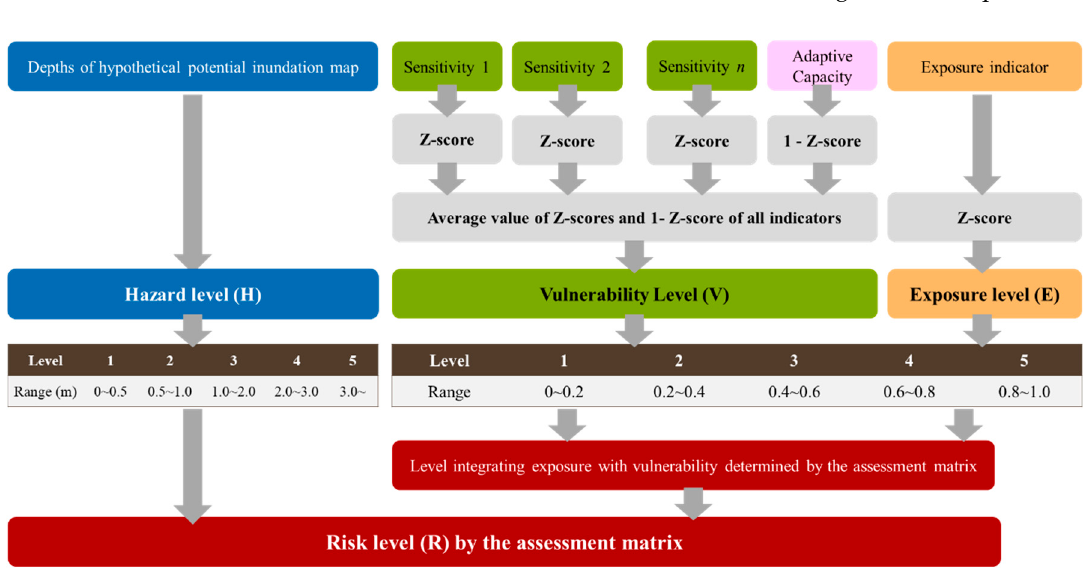
Figure 7. The quantification approach for hazard (H), exposure (E), vulnerability (V), and climate risk (R) levels.